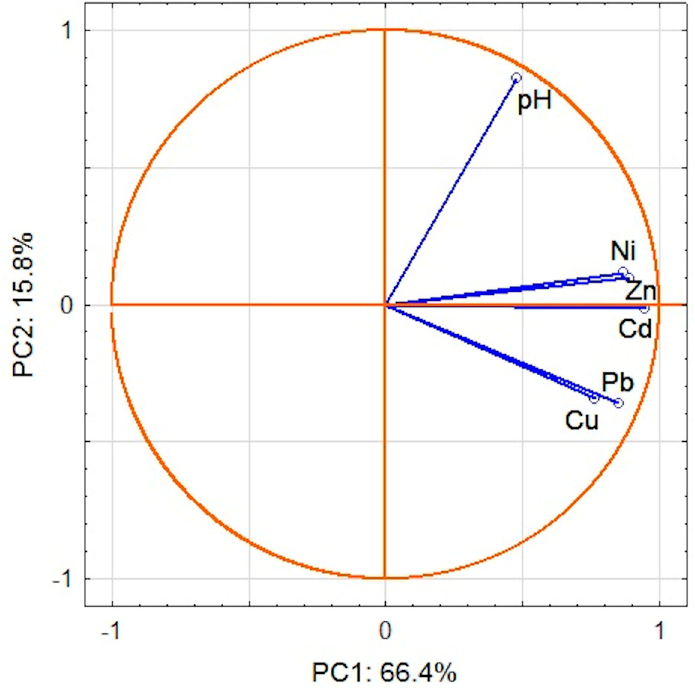
Figure 4. Loading plot of two main components PC1 and PC2.